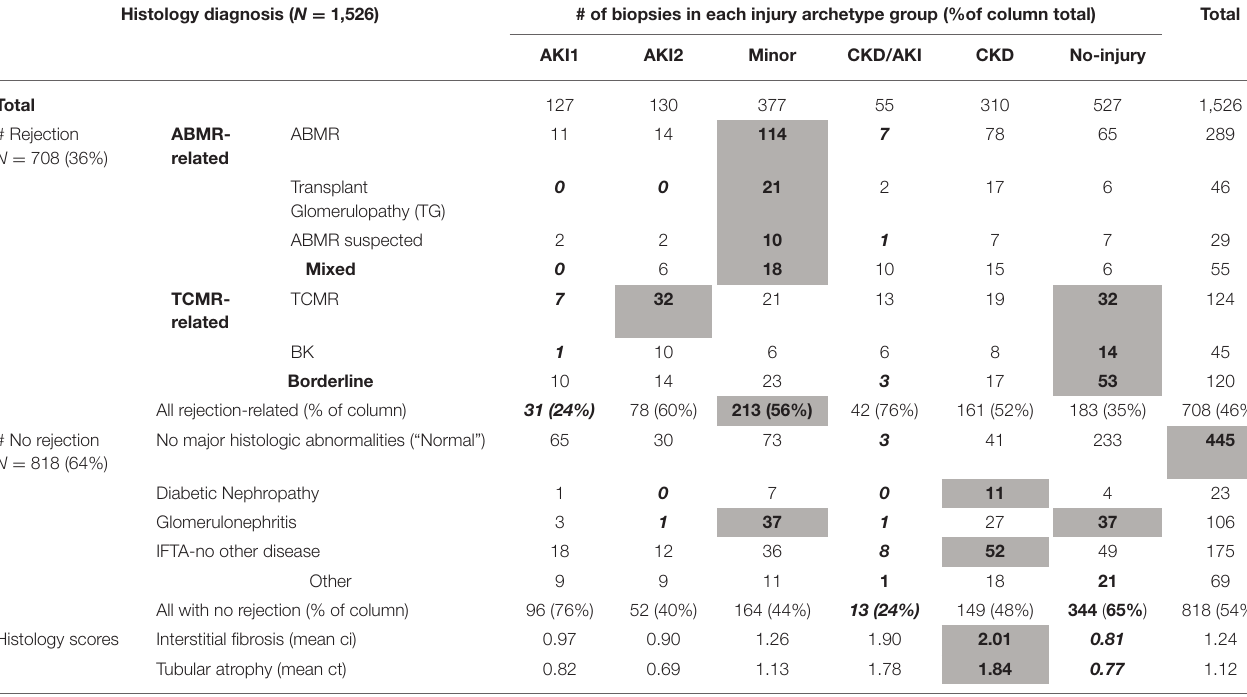
TABLE 4 | Distribution of histological diagnoses in the injury archetype groups (grouped by highest injury score) ( N = 1,526). Histology diagnosis ( N =